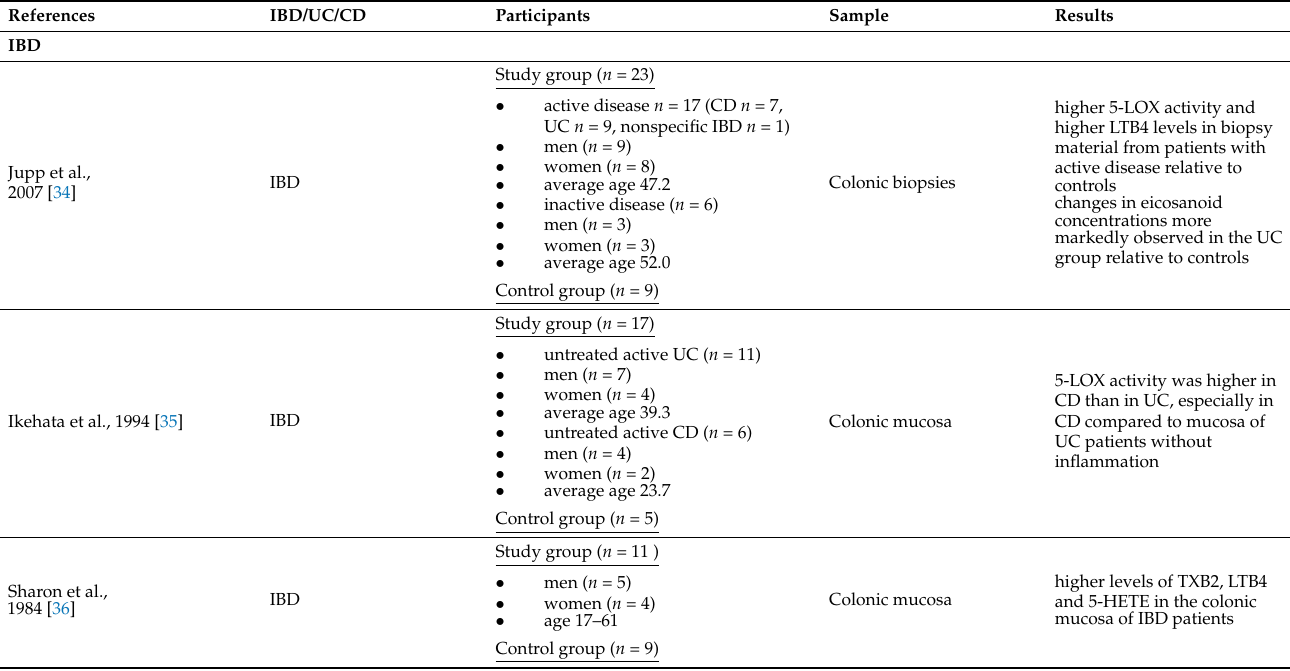
Table 5. Summary table of the research presented in the